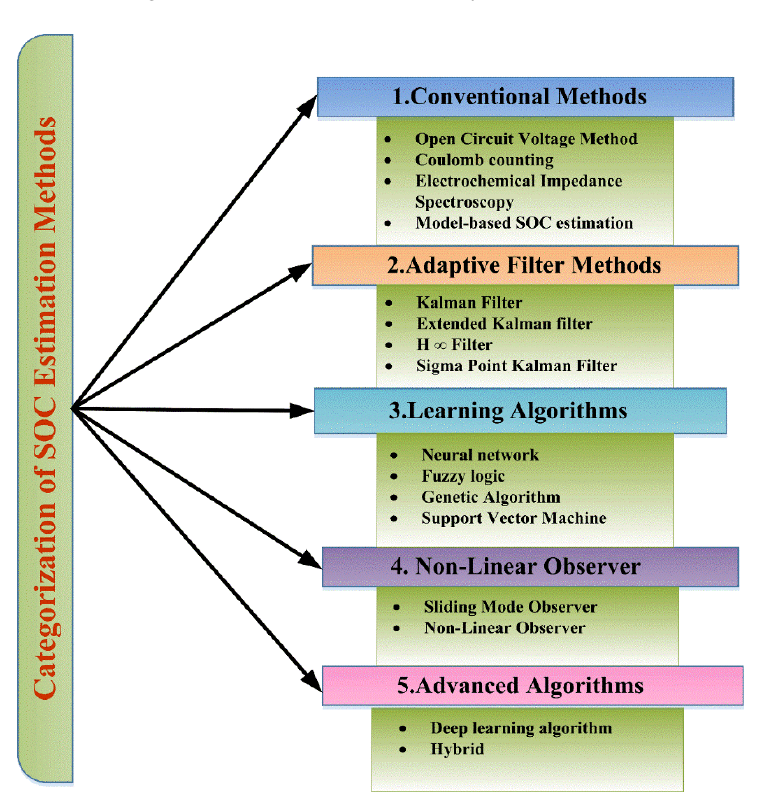
Figure 7. Categorization of methods for estimation of SOC.